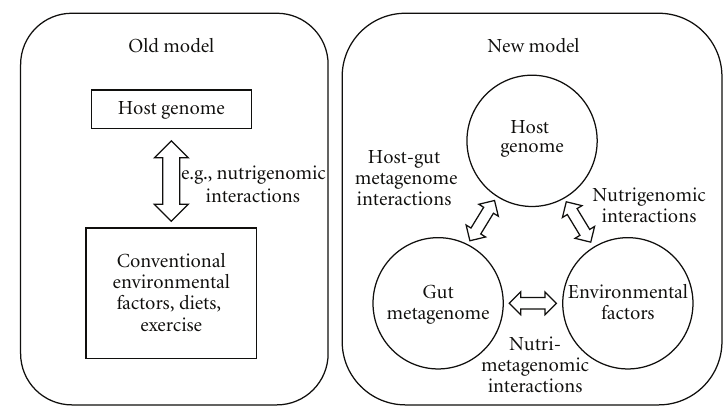
Figure 4: New and old models describing the factors that contribute to the development of metabolic diseases. An old model is based on direct interactions between the environmental factors and genetic variations of individuals (nutrigenomic interactions). A new model includes the emerging discoveries related to the gut microbiota and the host. Environmental factors such as dietary fats a ff ect the composition of the gut microbiota. Conversely, di ff erent profiles of gut microbiota regulate the production of short-chain fatty acids. Thus, the two way interactions can be described as nutri-metagenomic interactions. Crosstalks between the host and gut microbiota can also happen (host- metagenome interactions). Evidence that mutations of a host gene lead to alterations of gut microbiota profile and that mice colonized with di ff erent gut microbiota have di ff erent metabolic phenotype s supports the host-metagenome